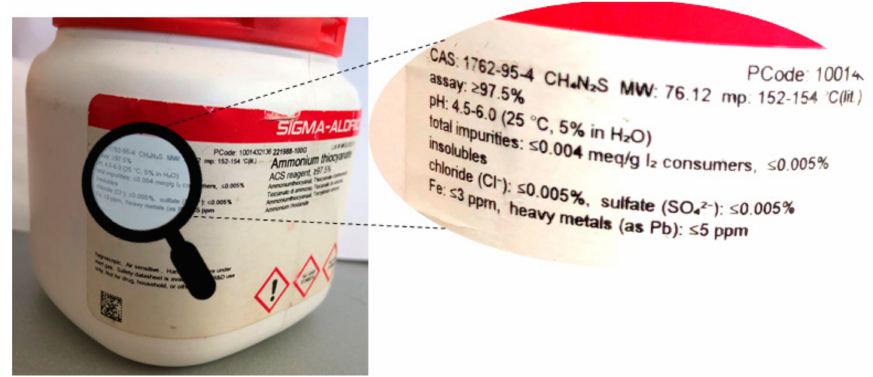
Figure 1. A commercial sample of ACS reagent ammonium thiocyanate with ≥ 97.5% purity. The remaining 2.5% mass is composed of various impurities is shown on the side of the container or listed in typical data sheets accompanying such a